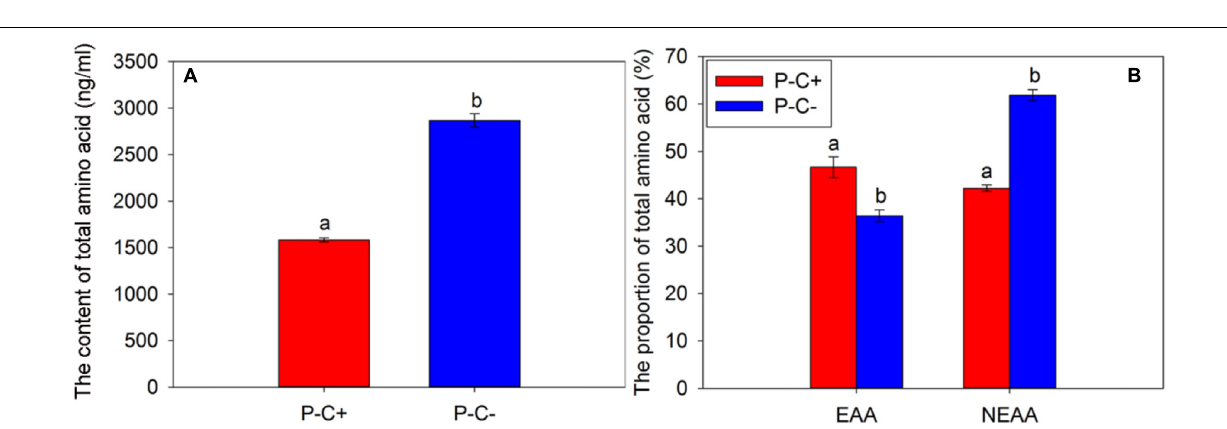
FIGURE 3 | The content of total amino acids (A) and the proportions of EAAs and NEAAs (B) in the Asian citrus psyllid (ACP) adults feeding on C Las-infected and C Las-free citrus plants. “P+” and “P − ” represent C Las positive and negative psyllids, respectively, and “C+” and “C − ” represent C Las-infected and C Las-free citrus pants, respectively. EAA, essential amino acids; NEAAs, non-essential amino acids. Values are represented as mean ± SE, and different letters over the bars mean significant differences between groups at P <